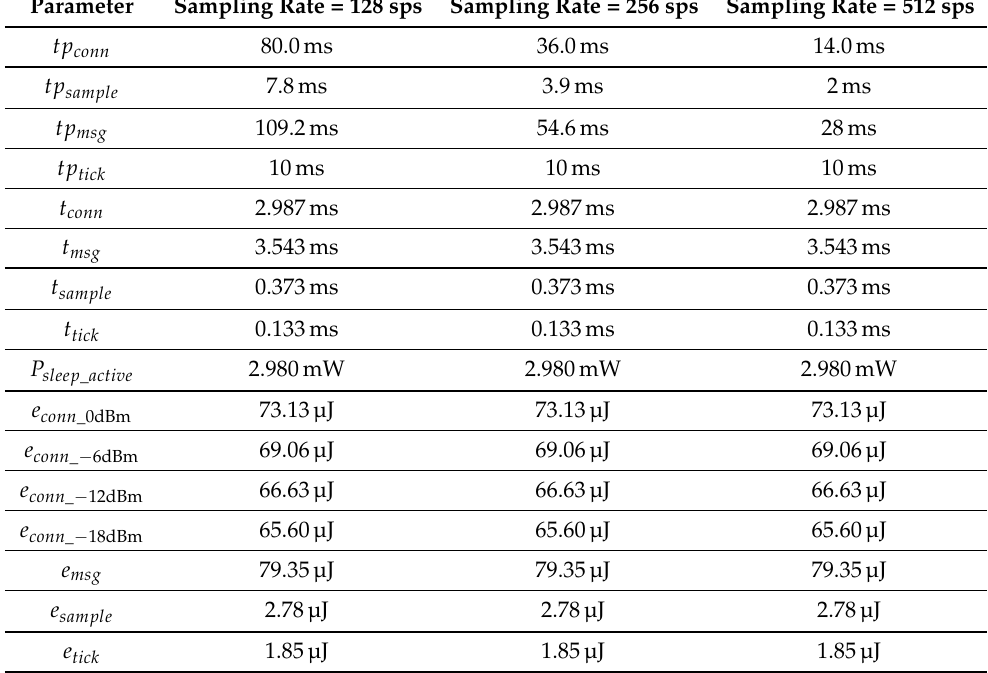
Table 4. BLE active mode evaluation